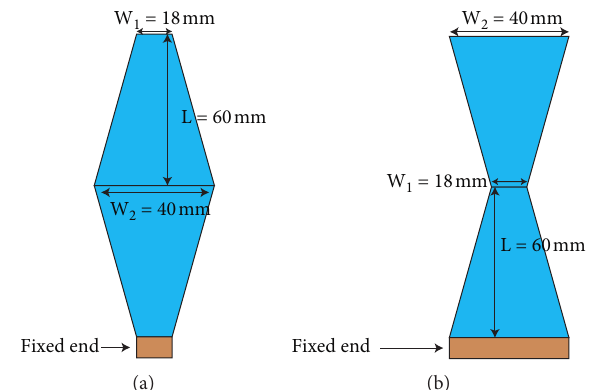
Figure 4: The top-down view of the two-piece piezoelectric trapezoidal beam designs. (a) Subplot of the first two-piece trapezoidal beam design, and (b) subplot of the second two-piece trapezoidal beam design. W 1 is the shorter width, W 2 is the longer width, and L is the length of one single plate.